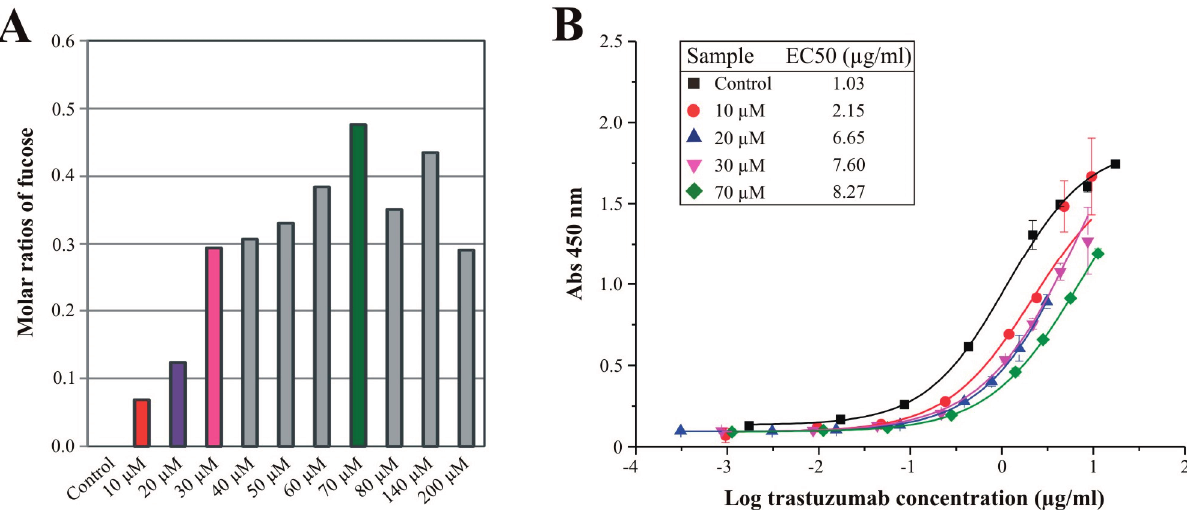
Figure 7. ( A ): Molar ratios of fucose derived from glycans of recombinant trastuzumab as determined by HPAEC-PAD. CHO RMD cells were treated with raising concentrations of PEG 4 Fuc (compared to an untreated control) under serum-free conditions for three days. Ratios are given related to mannose = 3 (based on the composition of a N -glycan core structure); ( B ): Binding curves of histidine-tagged Fc γ RIIIa to trastuzumab variants exhibiting differential fucosylation in consequence of PEG 4 Fuc treatment of the CHO RMD expression cell line. Cells were supplied with selected concentrations of PEGylated fucose (compared to an untreated control) under serum-free conditions for three days. Respectively, purified trastuzumab samples were analyzed in a Fc γ RIIIa binding assay. Points indicate the median absorption at 450 nm ± deviations of duplicates. The inset table displays the median EC50 values determined by a four-parameter logistic curve fit